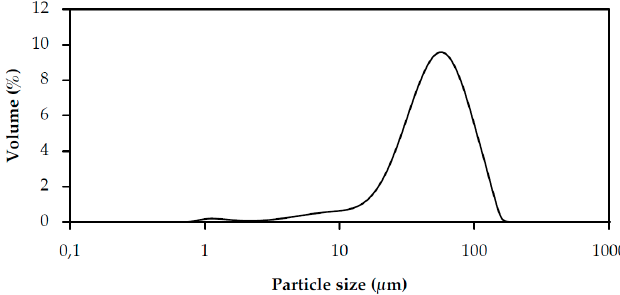
Figure 1. Quercus Suber Bark (QSB) particle size distribution (mean, n = 6).